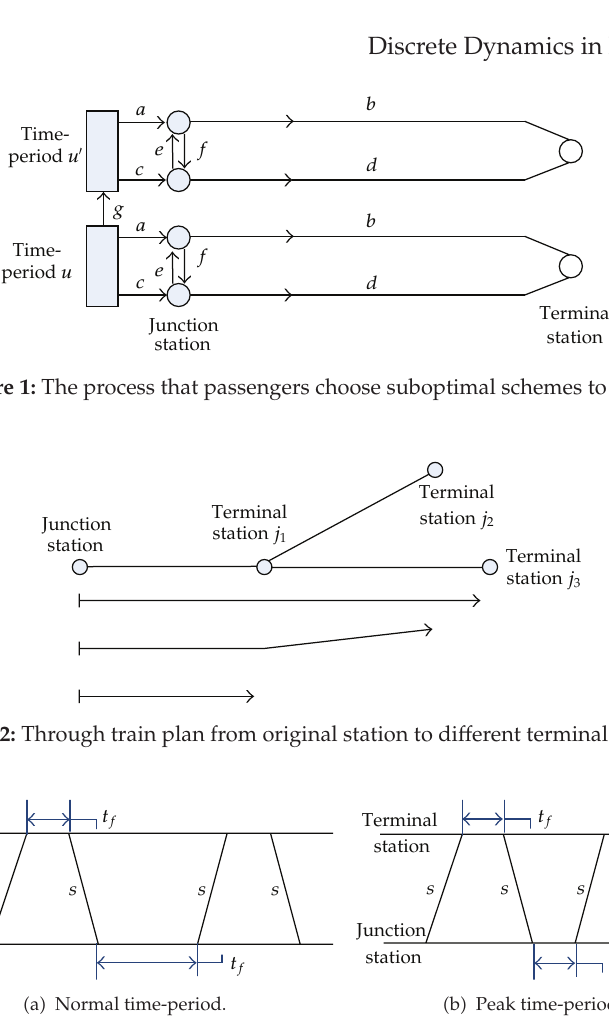
Figure 3: The operation mode of train-sets on fixed railway